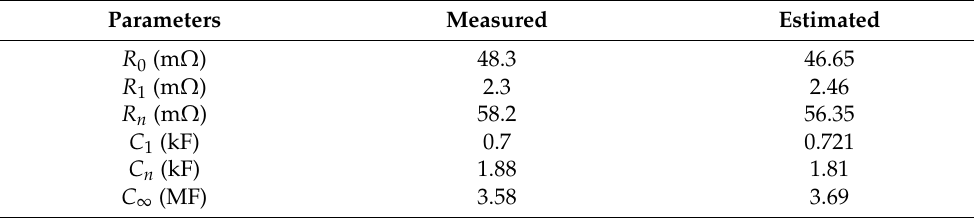
Table 7. Estimated Circuit Parameters.